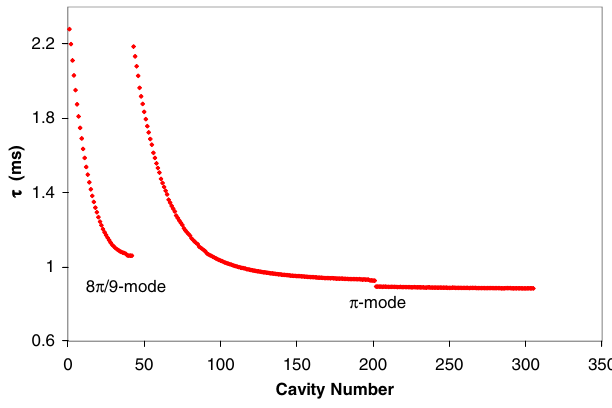
FIG. 6. (Color) The cavity time constant as a function of cavity number in the high energy section of the modified PD.